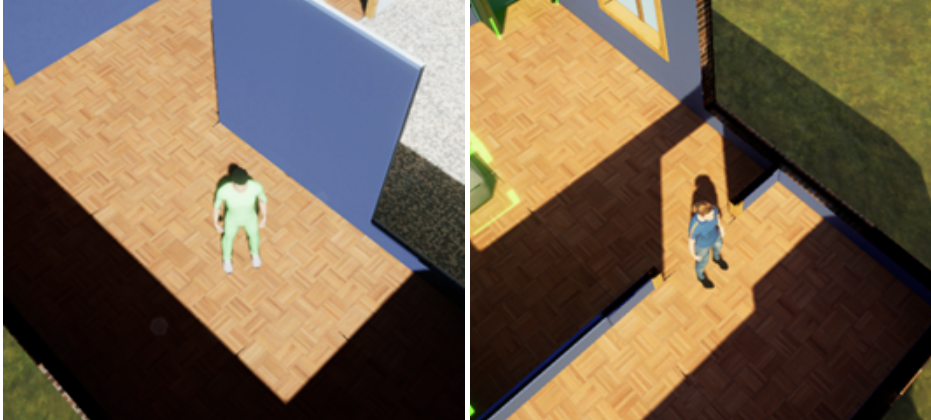
Figure 4. Care giver character ( left ) and the stroke survivor ( right ) in the